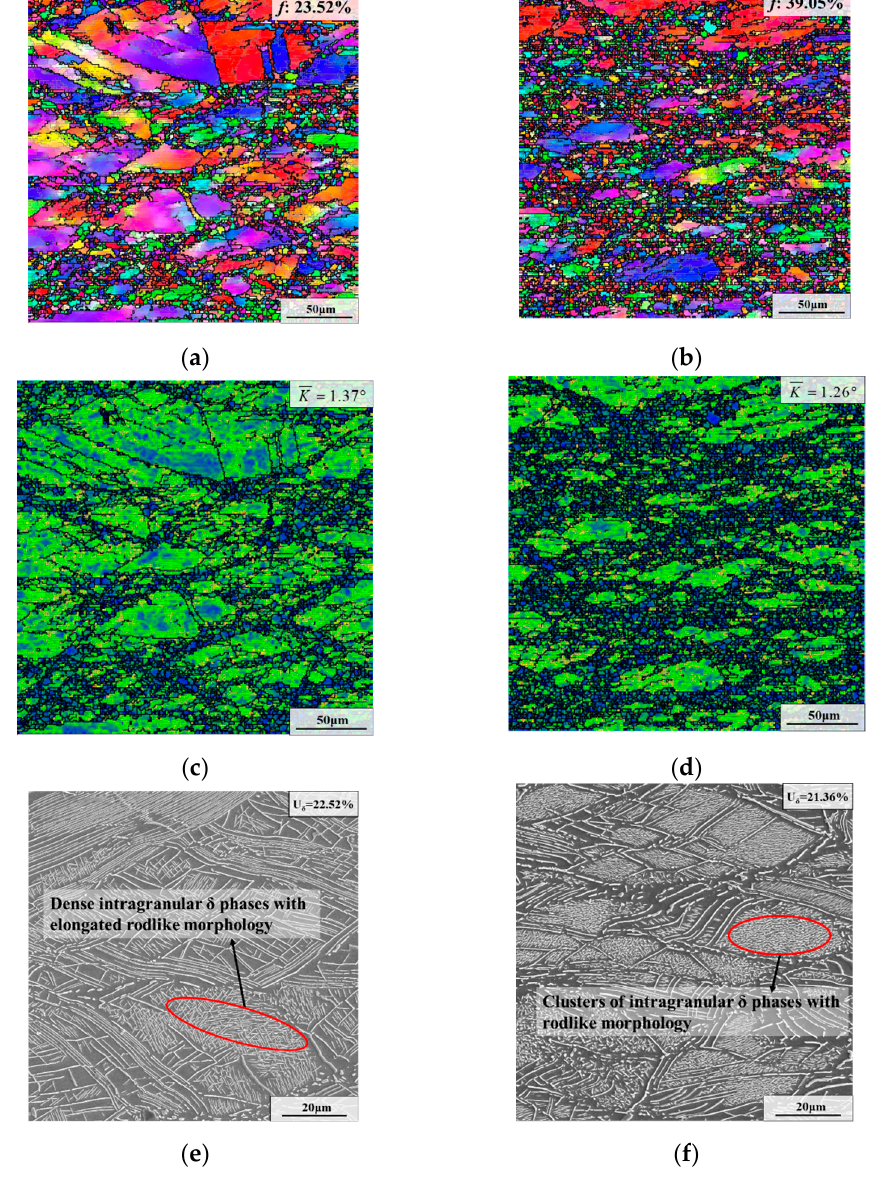
Figure 8. Microstructures after the first annealing stage with varying strain rates of: ( a , c , e ) 0.001 s − 1 ; ( b , d , f ) 0.01 s − 1 . (The deformation temperature is 950 ◦ C, and the true strain is